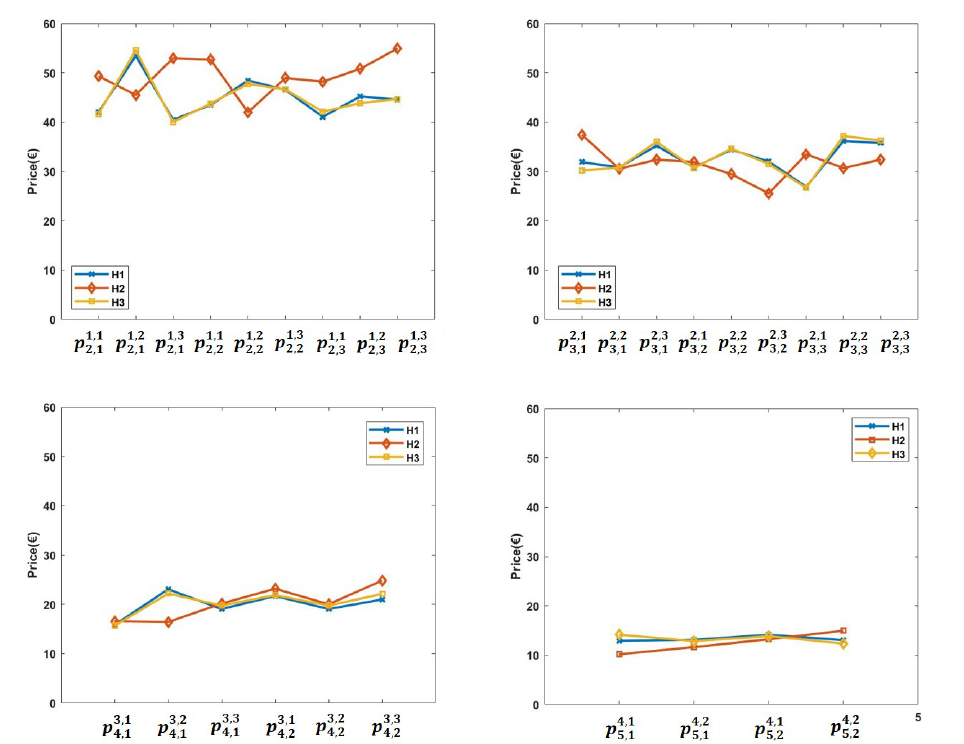
Figure 14. The values of prices ( (cid:164) /ton) for getting H 1 , H 2 and H 3